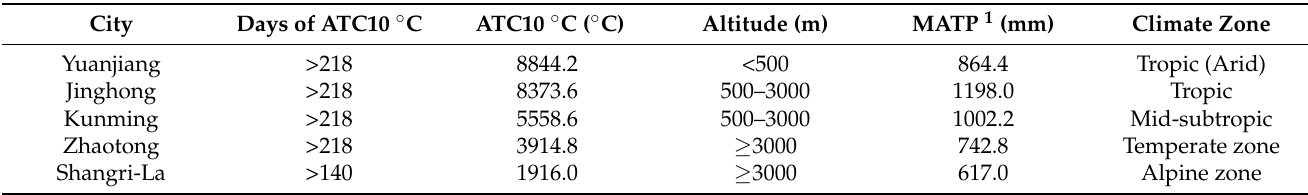
Figure 1. Geographic distribution of the cities considered in this study along with their background climate (SRL: Shangri-La; ZT: Zhaotong; KM: Kunming; YJ: Yuanjiang; JH: Jinghong; MATP: Mean annual precipitation; Data source: http://www.resdc.cn/ (accessed on 12 October 2021), DOI: 10.12078/2017121301). Table 1. Information on the selected